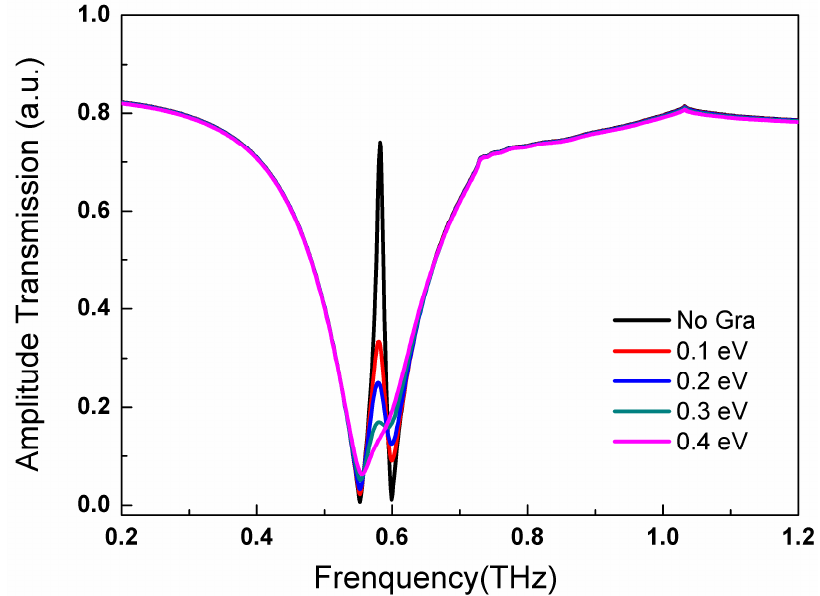
Figure 4. The simulated amplitude transmission spectra of the proposed metamaterials at different Fermi energy of single-layer graphene.